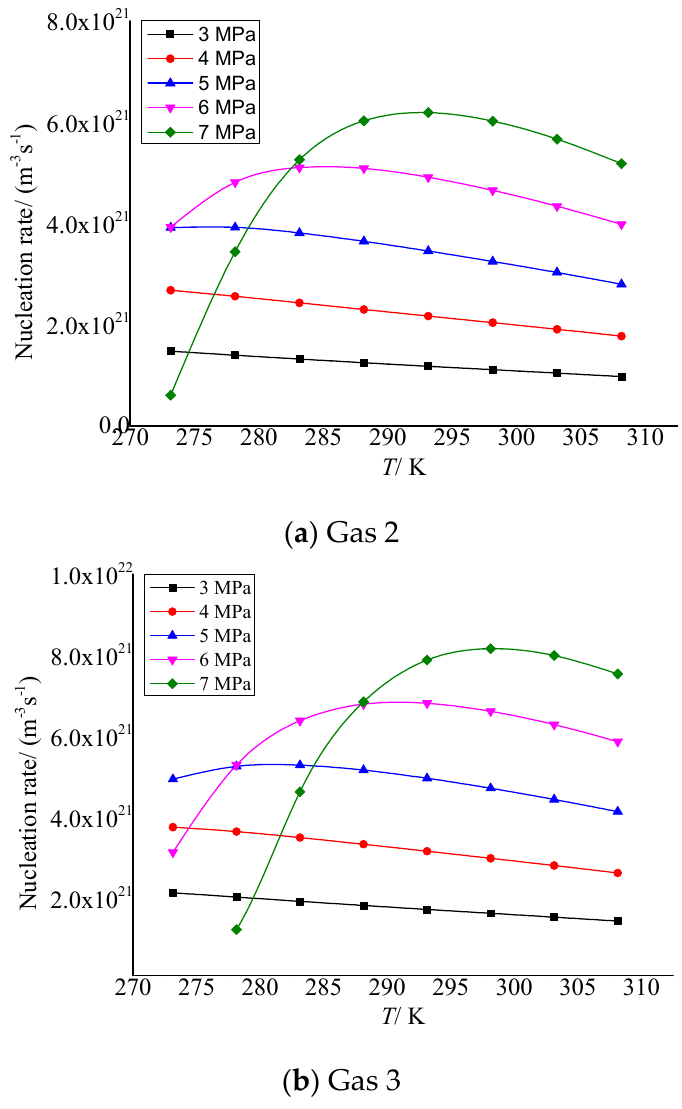
Figure 4. Curve of nucleation rate with temperature.